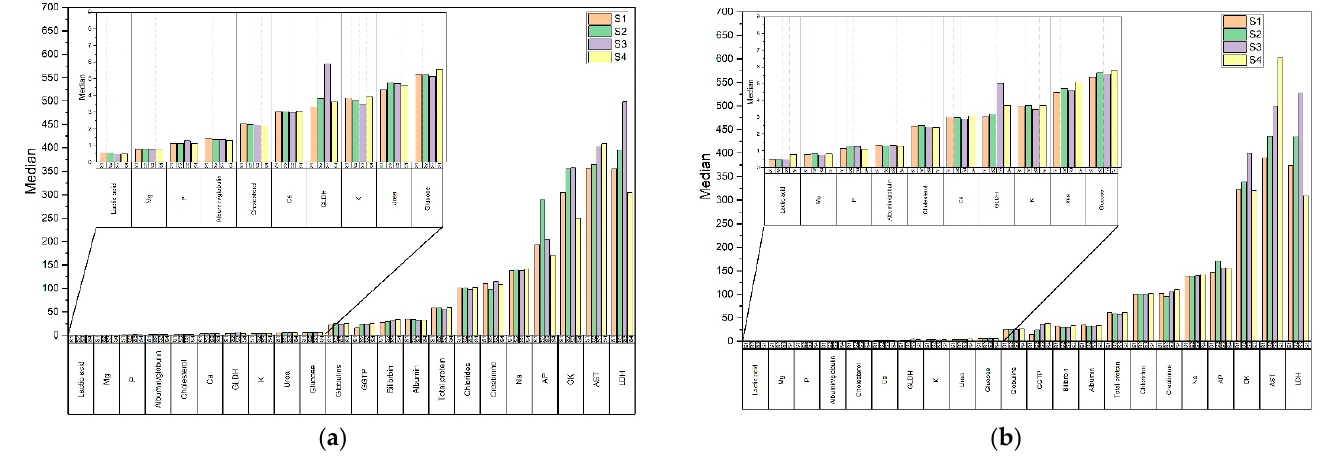
Figure 2. The median values of biochemical blood analysis for: ( a ) supplemented group (G0); ( b ) control group (G1); day 1 (S1), day28 (S2), day 56 (S3), day 84 (S4).